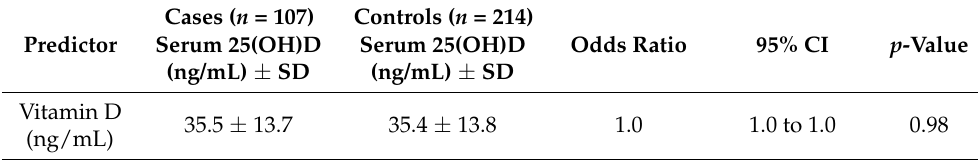
Table 3. Pre-diagnosis—conditional logistic regression.